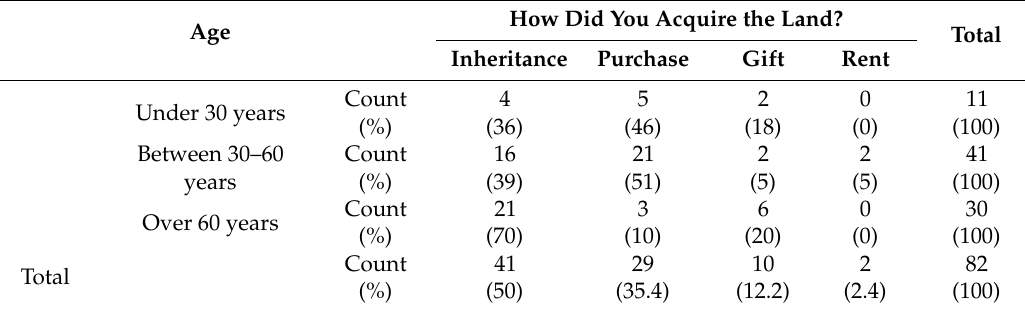
Table 1. Mode of acquisition of land by age of